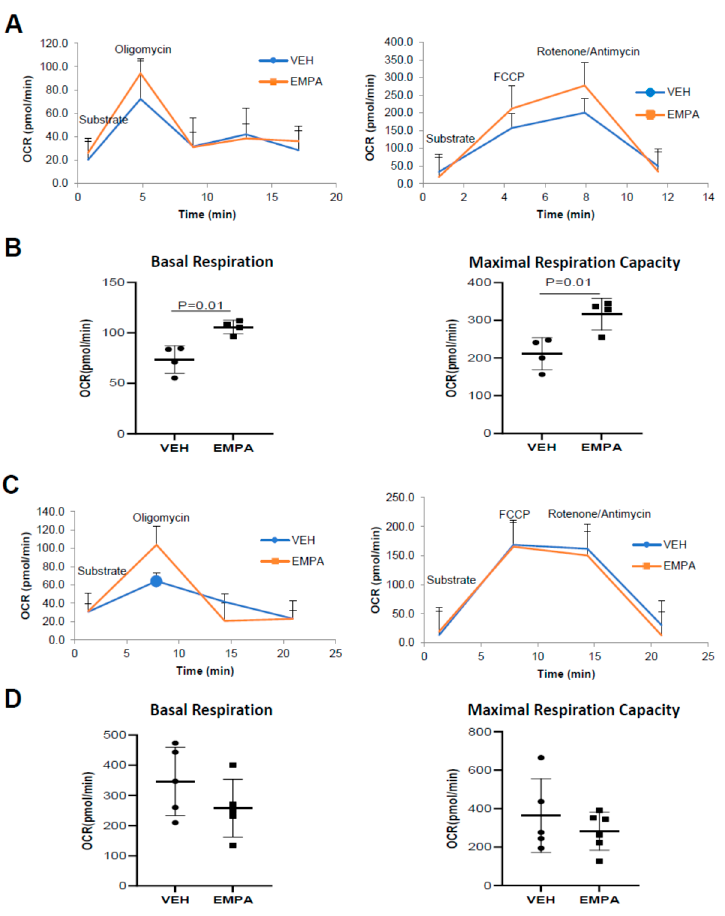
Figure 4. Post-infarction treatment with EMPA boosts mitochondria-linked cardiac energetics of WT but not PKO mice. Mice were subjected to PCAL and treated with vehicle (0.5% w/w hydroxyethyl cellulose VEH) or EMPA (10 mg/kg/day). Mitochondria isolated from heart tissue 14 days after PCAL and oxygen consumption was measured using Seahorse mito stress test. ( A ) Respiration profile of isolated mitochondria from WT mice treated with VEH or EMPA; ( B ) quantification of basal respiration and maximal respiratory capacity of mitochondria from WT mice ( n = 4); ( C ) respiration profile of isolated mitochondria from PKO mice treated with VEH or EMPA; ( D ) quantification of basal respiration and maximal respiration capacity of mitochondria from PKO mice ( n ≥ 5).